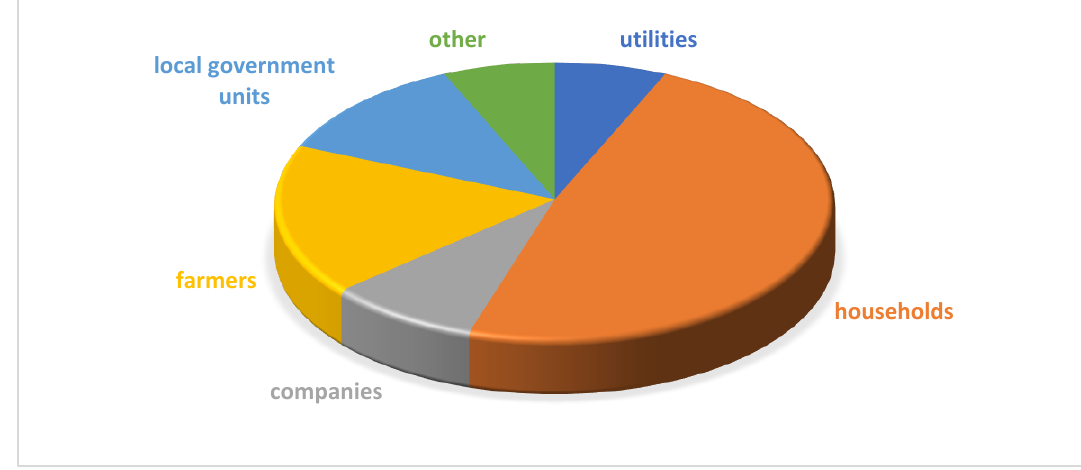
Figure 8. The largest consumer in the commune.